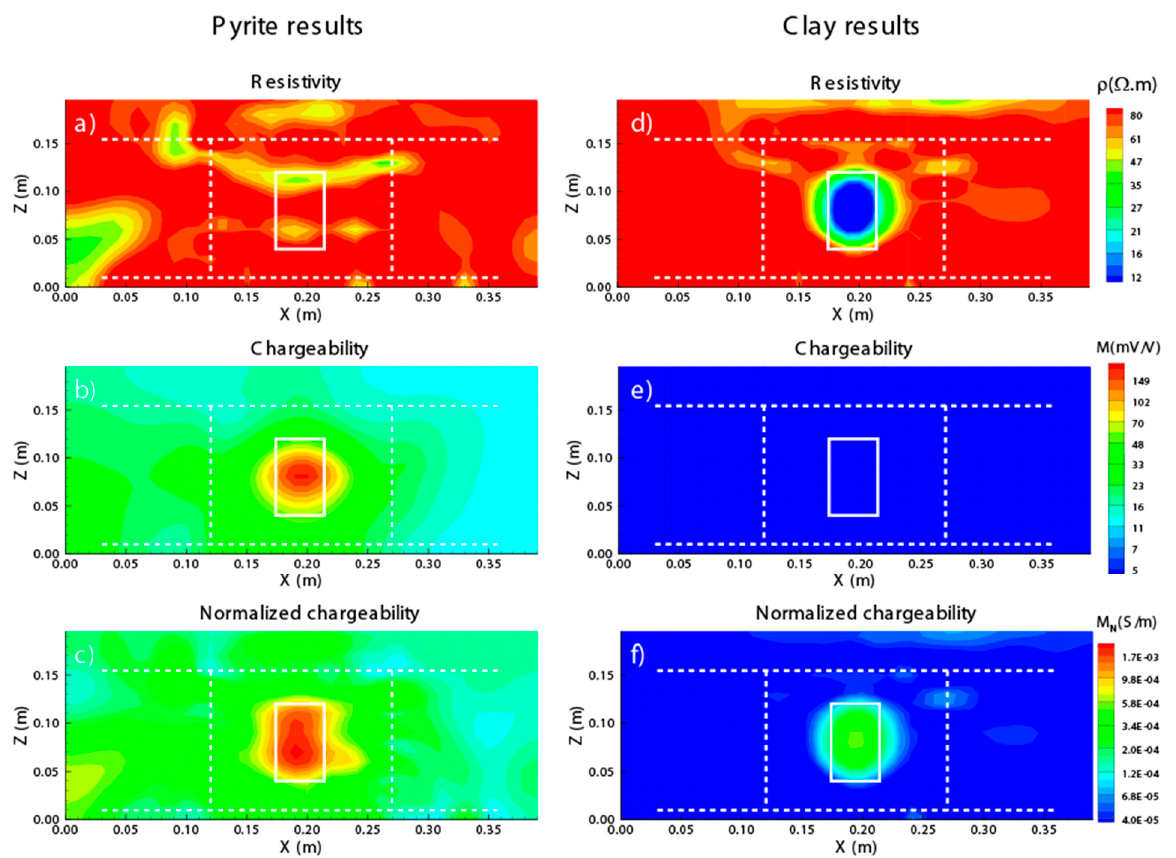
Figure 25. Comparison of the resistivity, chargeability, and normalized chargeability tomograms between localized pyrite and localized bentonite in a sandy background. ( a ) Resistivity tomography in the case of disseminated pyrite in a sandy background. ( b ) Chargeability tomography in the case of disseminated pyrite in a sandy background. ( c ) Normalized chargeability tomography in the case of disseminated pyrite. ( d ) Resistivity tomography in the case of bentonite. ( e ) Chargeability tomography in the case of disseminated pyrite. ( f ) Normalized chargeability tomography in the case of bentonite. Adapted from [100].